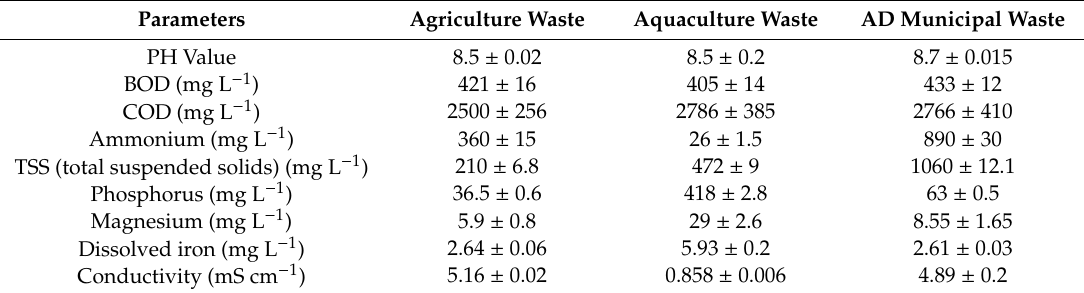
Table 2. Physicochemical characteristics of the three waste sources used as media for N. oceanica cultivation (the data presented with